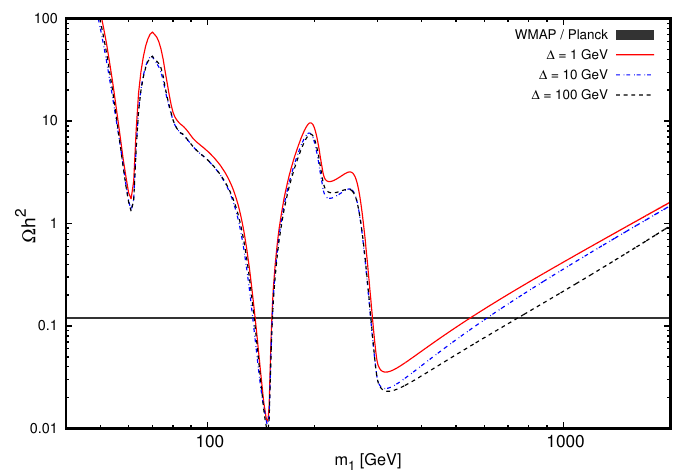
Figure 3 . DM relic density is shown as a function of DM mass for three values of the mass splitting, (cid:1) = 1 ; 10 ; 100 GeV. Input parameters are: g 1 = 0 : 9, g 2 = 0 : 1, g 12 = 0 : 9, (cid:21) 2 = 0 : 1, sin (cid:18) = 0 : 05 and m s = 300